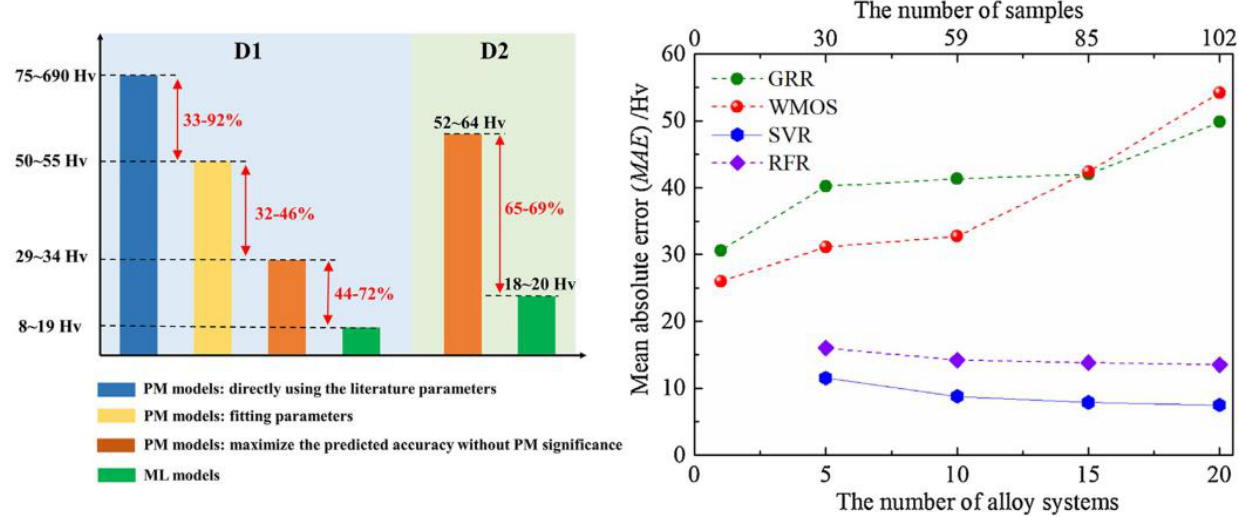
Figure 19. Semi-quantitative and quantitative analysis of the prediction accuracy for ML and PM methods [186]. (Reprinted with permission from Ref. [186]. Copyright 2021 Elsevier).